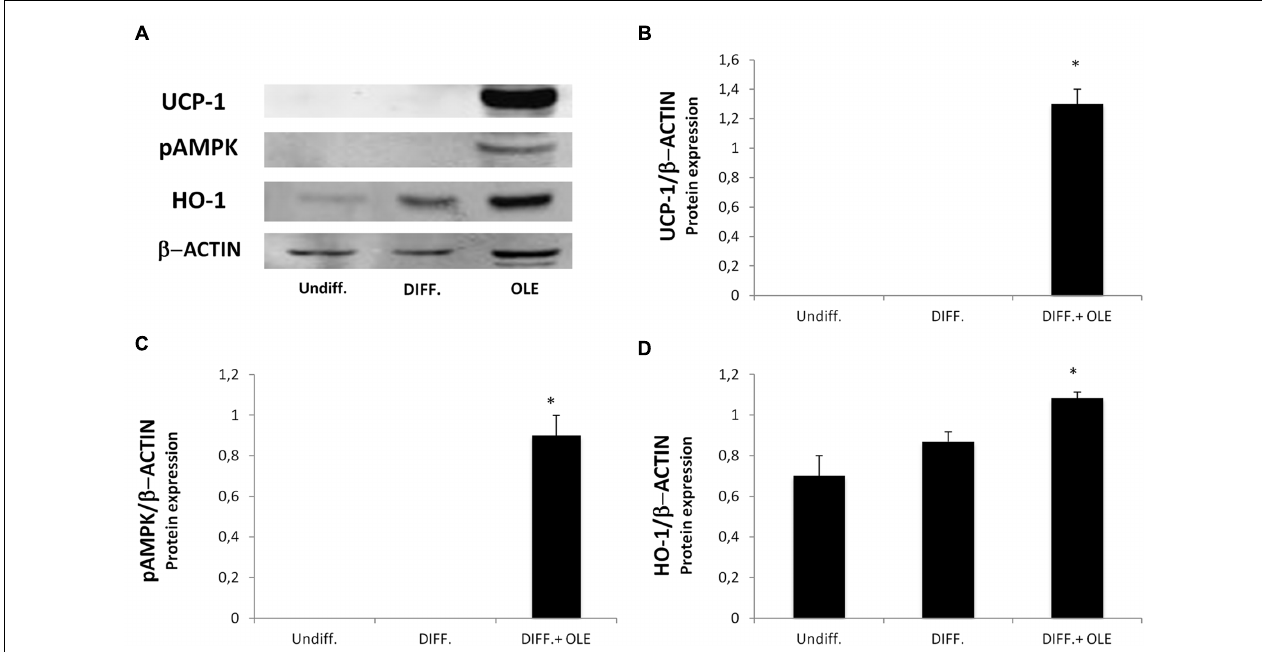
FIGURE 6 | Analysis of protein expression, evaluated by Western Blot, of cells treated with OLE during adipogenic differentiation. The figure shows bands of western blots (A) and the densitometric analysis of UCP1 (B) , pAMPK (C) , and HO-1 protein expression (D) . All values are expressed as mean ± SEM of three experiments ( n = 3) in duplicate. The values are expressed as ratio of protein on the β -Actin expression. ( ∗ P < 0.05 versus